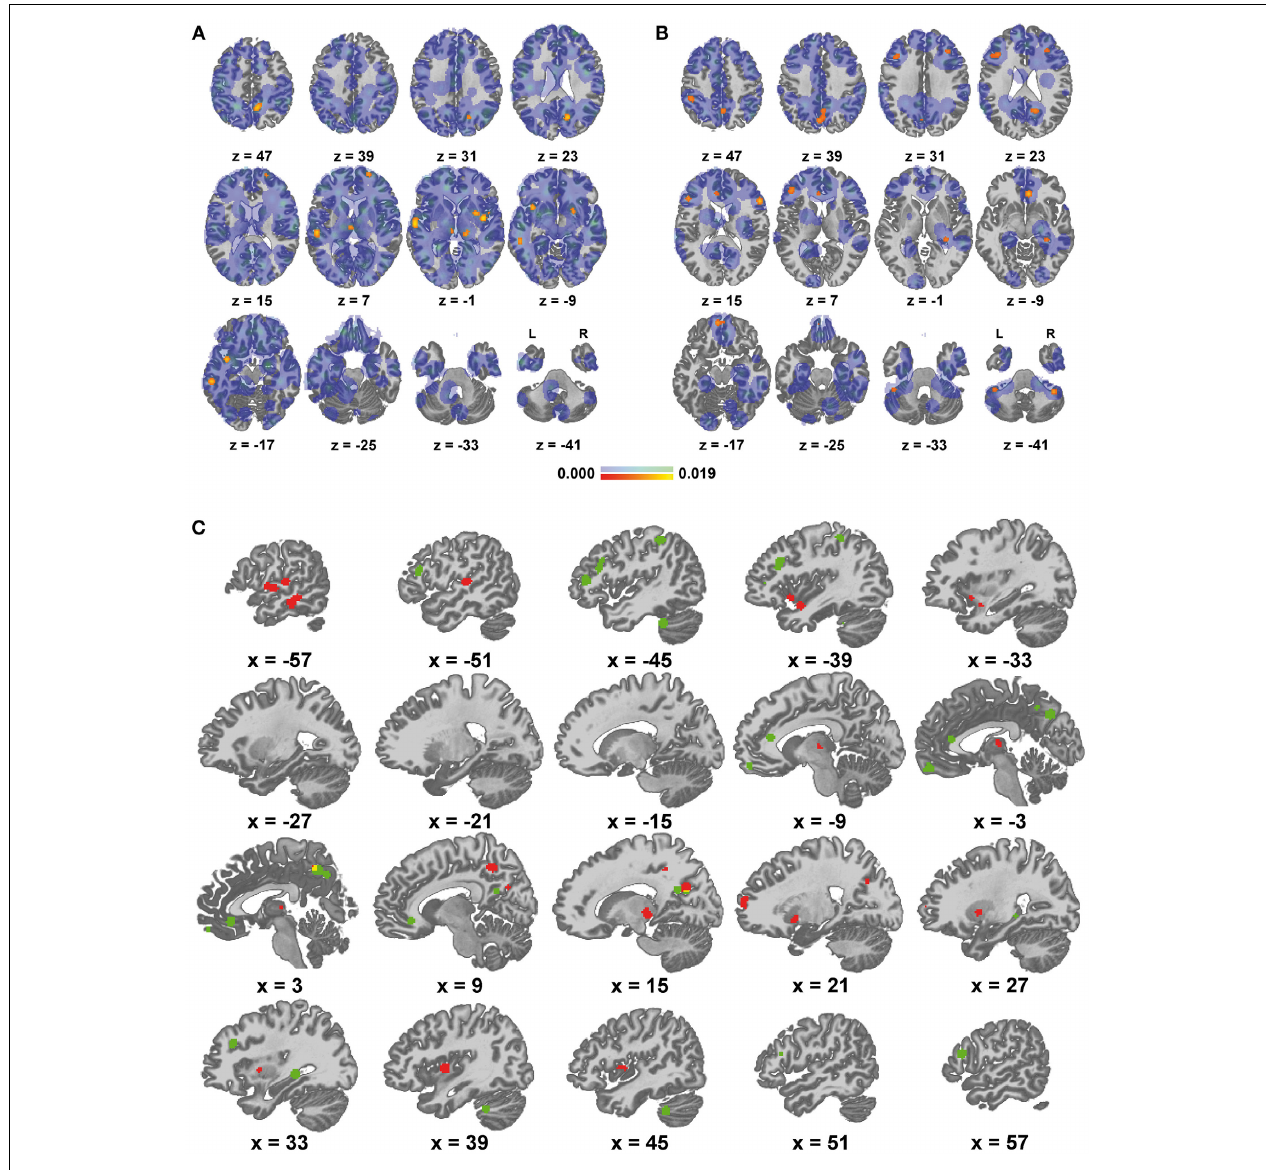
FIGURE 1 | Areas of altered functional connectivity/activity in depression compared to controls. (A) Red to yellow: significant meta-analytic results ( p < 0 . 05) in group A (representing mainly decreased connectivity / function in depression), blue to green: